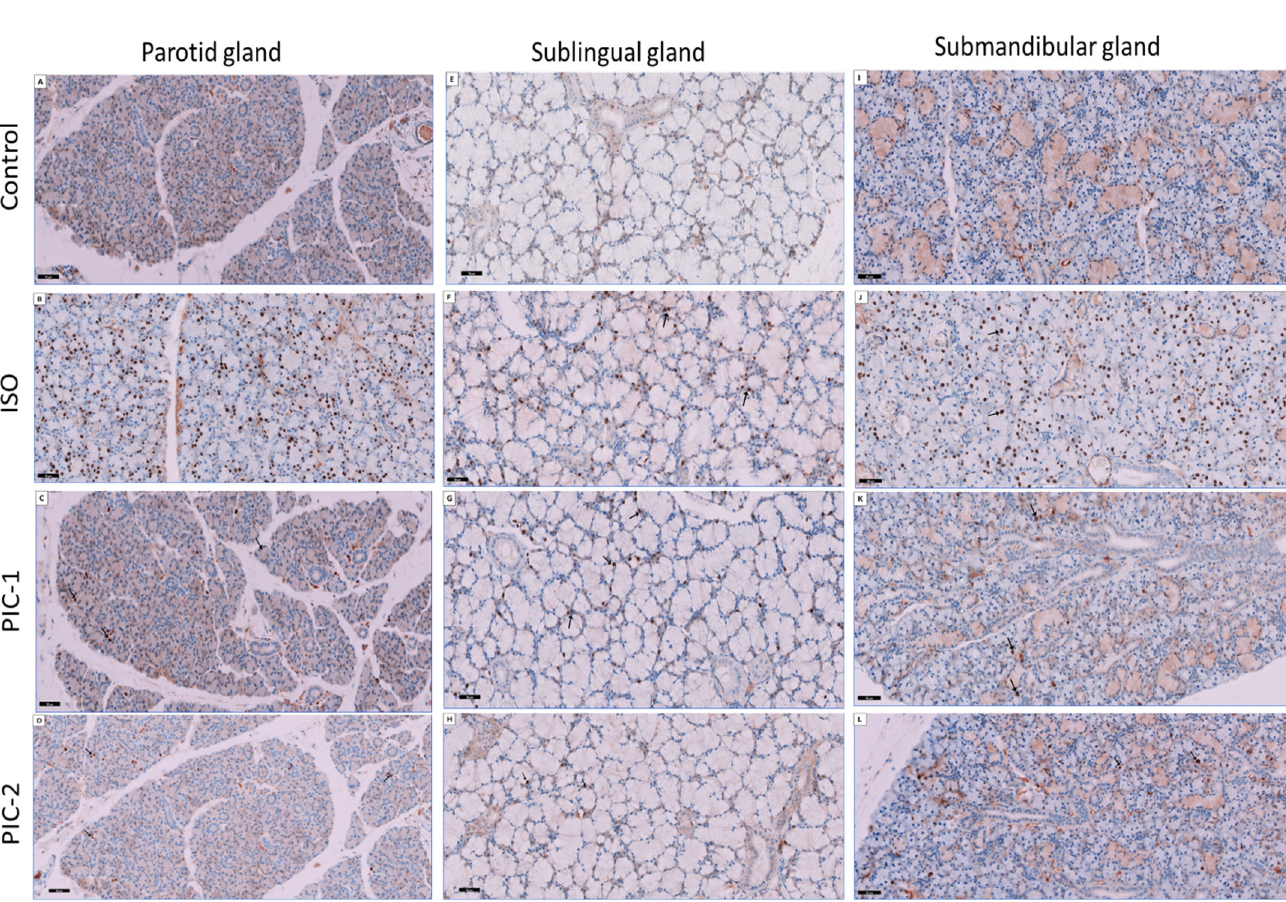
Figure 8. Sections of the three salivary glands (parotid ( A – D ), sublingual ( E – H ), and submandibular ( I – L ) glands) are stained. The control group shows few immunopositive staining to Ki-67 in the secretory acini and ducts. The ISO treated group shows marked increased numbers of immunopositive labeled nuclear staining in the secretory acini. The PIC-1 group shows an apparent decrease in the numbers of immunopositively labeled nuclear staining in the secretory acini and ducts as compared to the ISO group. The PIC-2 group reveal few immunopositive staining to Ki-67 in the secretory acini and ducts and appeared similar to the control group (immunohistochemical stain Ki-67; ×200).